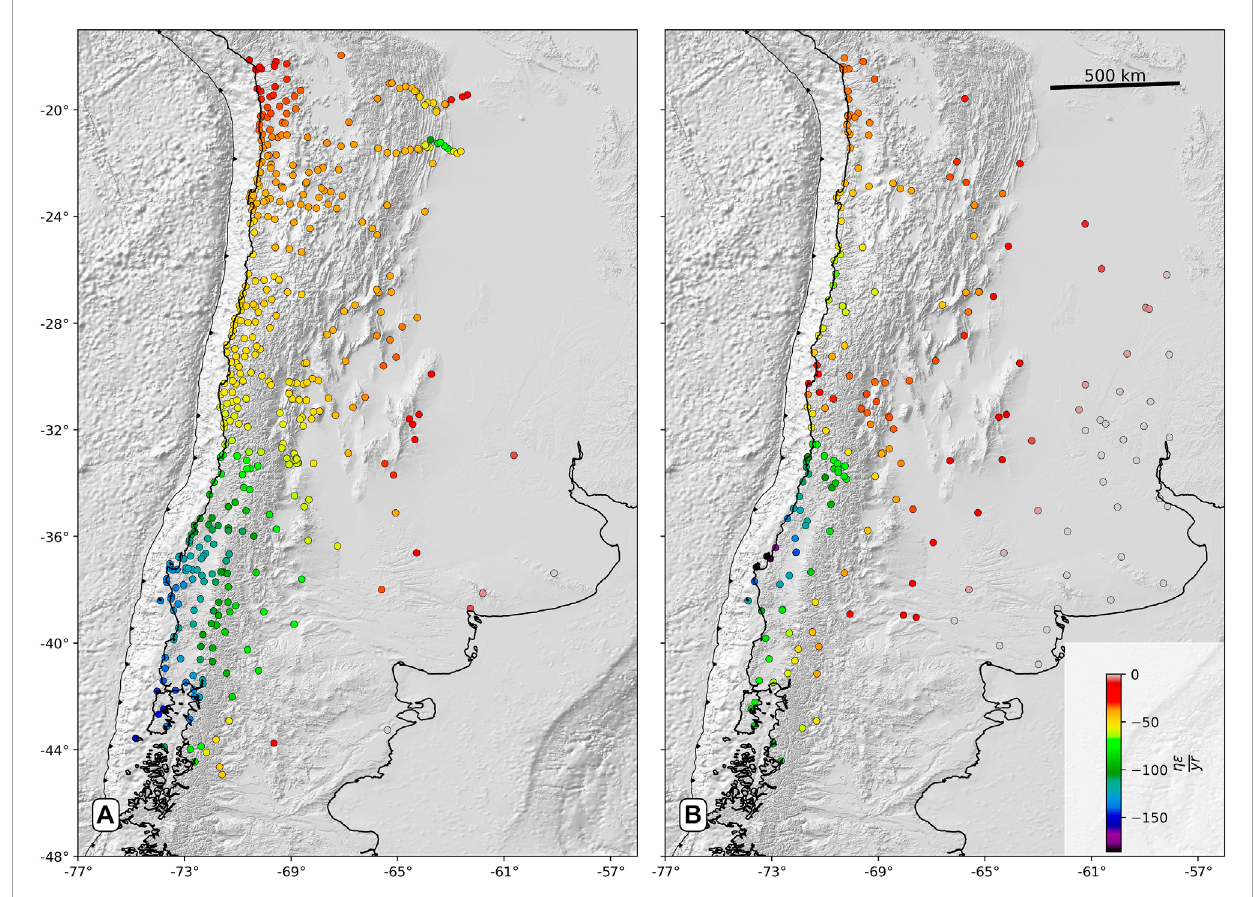
FIGURE 7 I 1 feature value for both periods colored with the same color scale. Pre-2014 (A) , 2018–2021 (B)